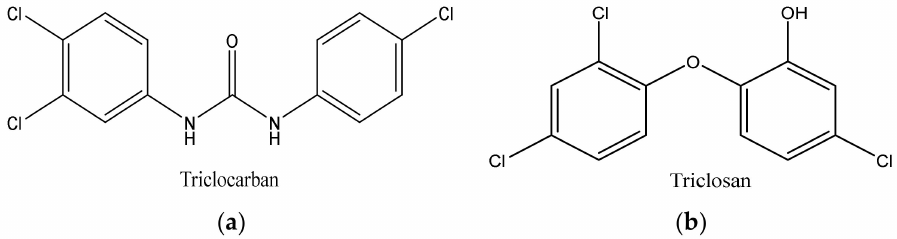
Figure 1. Structure of triclocarban ( a ) and triclosan ( b